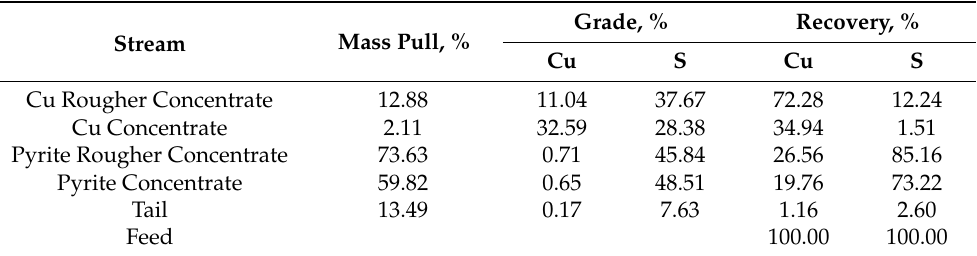
Table 7. Results of the open cleaner flotation test performed using a blend of Ore A:Ore B (50:50) flotation and 200 g/t KAX in pyrite flotation.